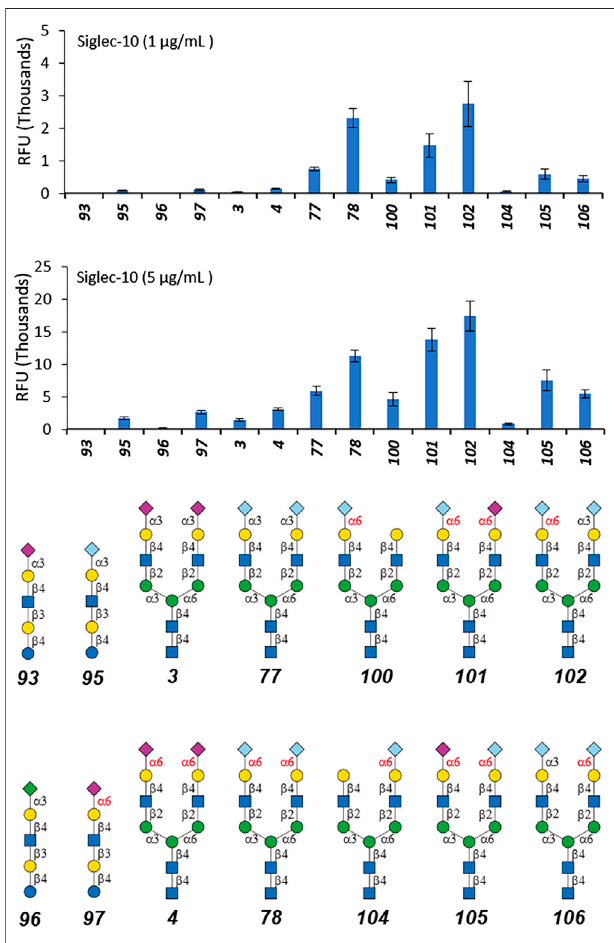
FIGURE 3 | Selective recognition of Neu5Ac-containing N -glycans by human Siglec-10.